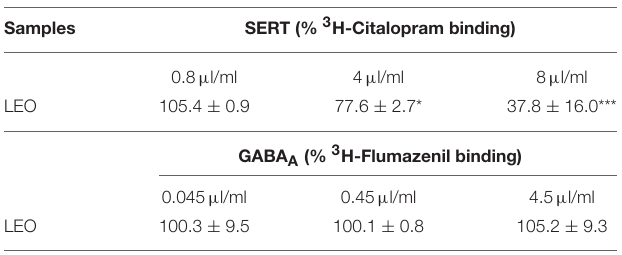
TABLE 1 | Activity of lavender essential oil (LEO) on the serotonin transporter (SERT) and GABA A ionotropic receptor. Samples